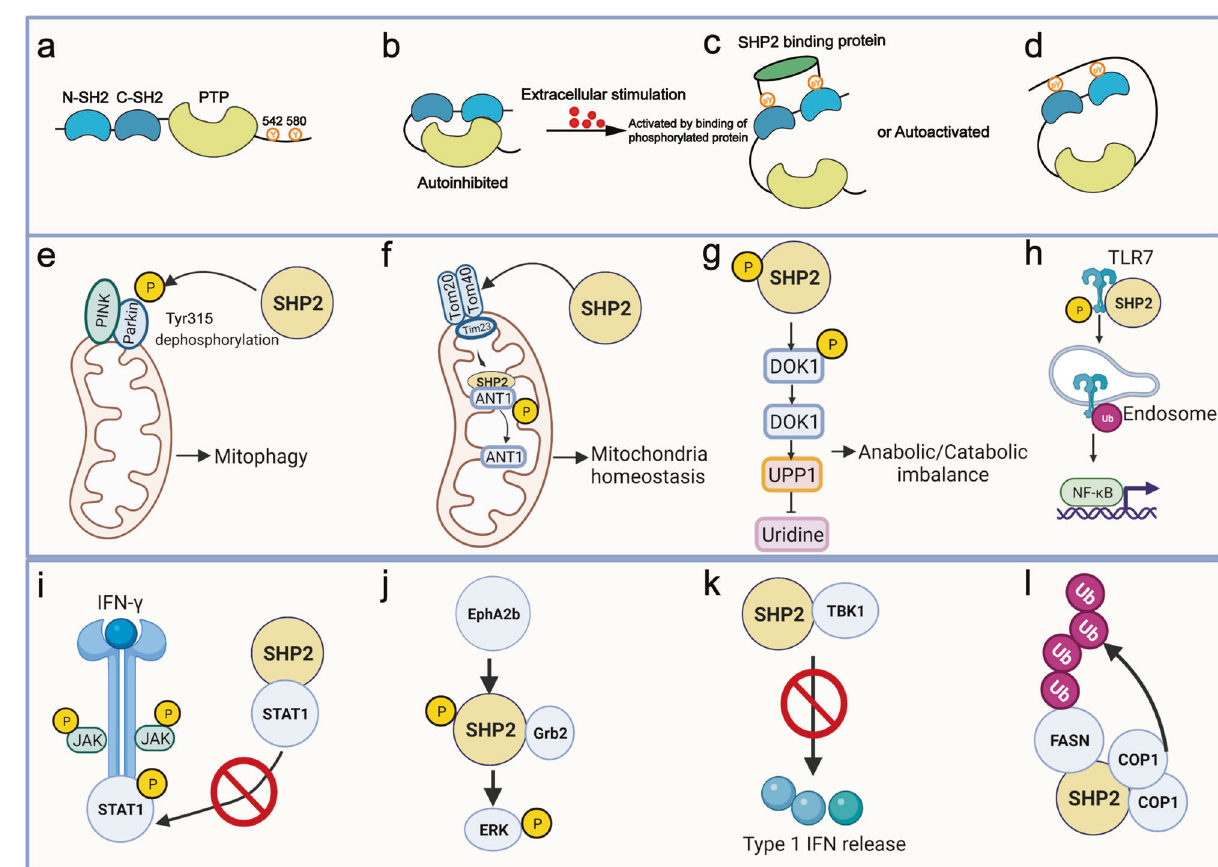
Fig. 5 The structure of SHP2 and its function-dependent or independent of phosphatase activity. a – d A schematic diagram of the activation state of SHP2. a The core structure of SHP2. SHP2 consists of two SH2 domains at the N-terminal (N-SH2 and C-SH2), one PTP catalytic domain, and two phosphorylated tyrosine residues at the C-terminal. b , c , d When stimulated with extracellular signals, SHP2 either converts from an autoinhibited state to an activated state upon the binding of phosphoproteins to its SH2 domain or it is autoactivated through phosphorylation at its Tyr site. e – h Four representative phosphatase-dependent functions of SHP2. e SHP2 is translocated into mitochondria, dephosphorylated the Tyr315 site of parkin and further activated by mediated mitophagy. 38 f In acute colitis conditions, SHP2 is moved